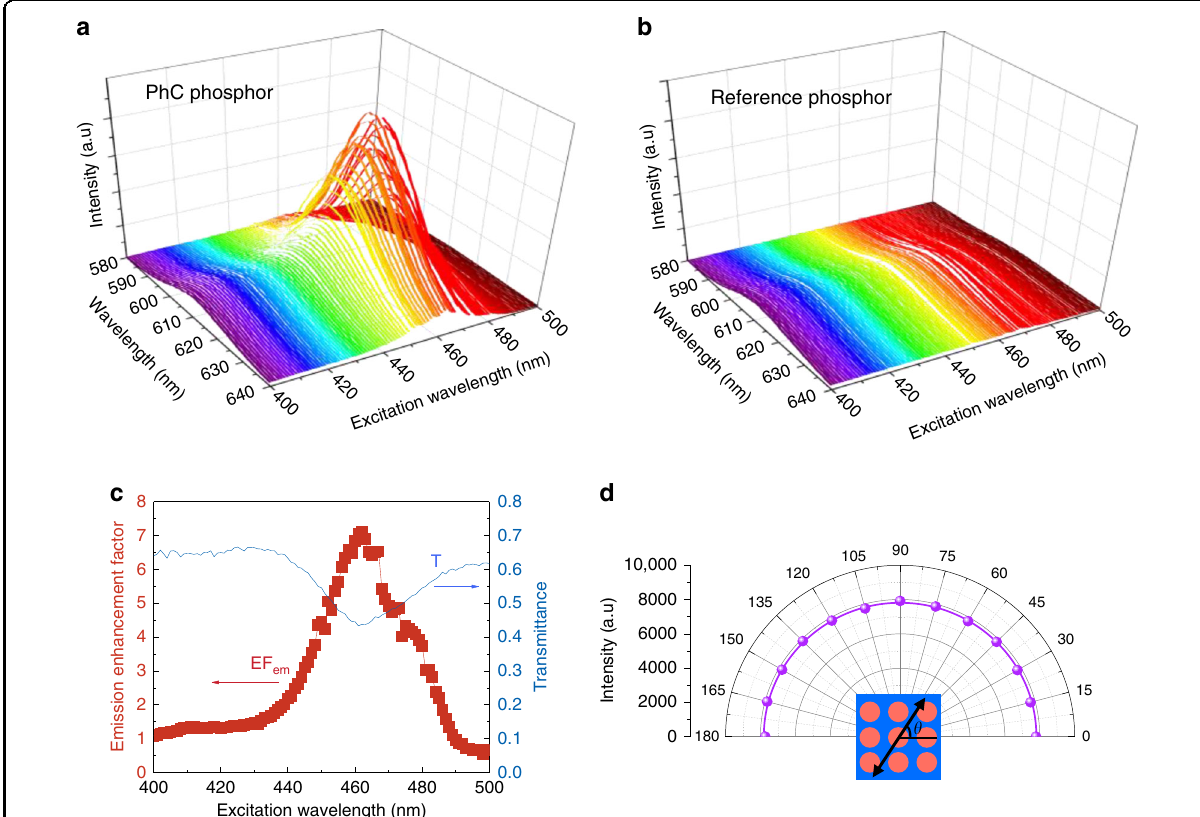
Fig. 3 Enhanced CQD fl uorescence of the 2D PhC phosphor. a , b Measured CQD fl uorescence spectra for a the 2D PhC phosphor and b the reference phosphor, both measured as a function of the excitation wavelength. c Emission enhancement factor plotted as a function of the excitation wavelength. Also shown for comparison is the measured transmittance spectra. d CQD fl uorescence intensity at the resonance wavelength, measured as a function of the polarization angle of excitation photons. The line is for reference. The inset is for identifying the polarization angle with respect to the square-lattice PhC